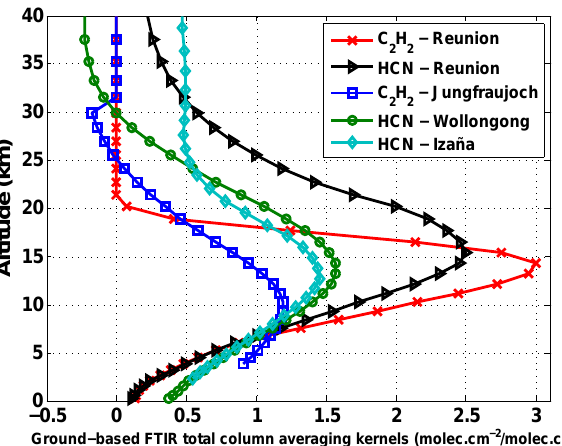
Figure 7. Total column averaging kernels of ground-based FTIR in moleccm − 2 /moleccm − 2 for C 2 H 2 at Reunion Island (red stars and line), HCN at Reunion Island (black circles and line), HCN at Wol- longong (green dots and line), HCN at Izaña (light blue diamonds and line) and C 2 H 2 at Jungfraujoch (blue squares and